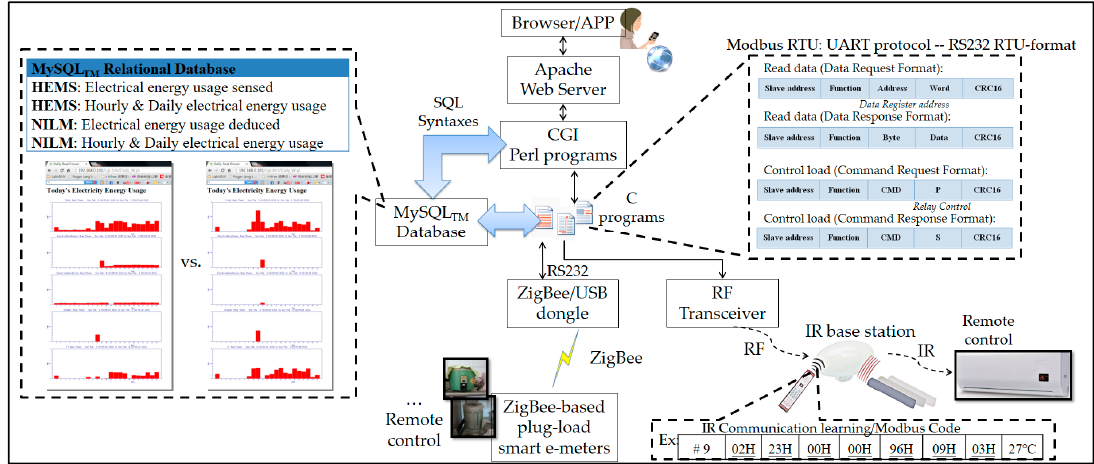
Figure 2. Flow of data stores, signal requests, and remote control of monitored electrical appliances in the IoT-oriented HEMS employing the novel hybrid ANN-PSO-integrated NILM proposed in this paper. DSM in the IoT-oriented HEMS is mainly realized through a heterogeneous network involving ZigBee, Radio Frequency (RF), and Infrared Radiation